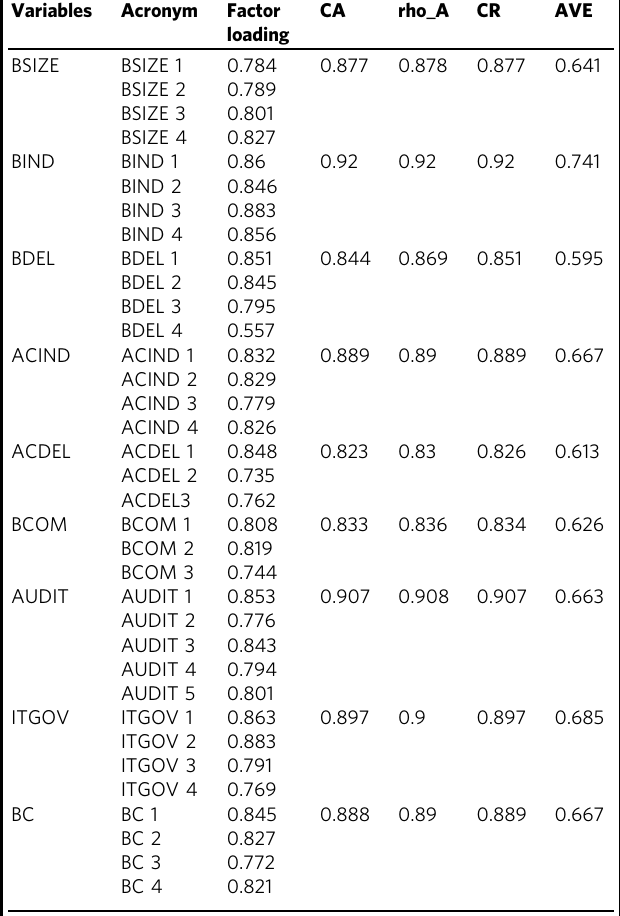
Table 5 Reliability and validity.